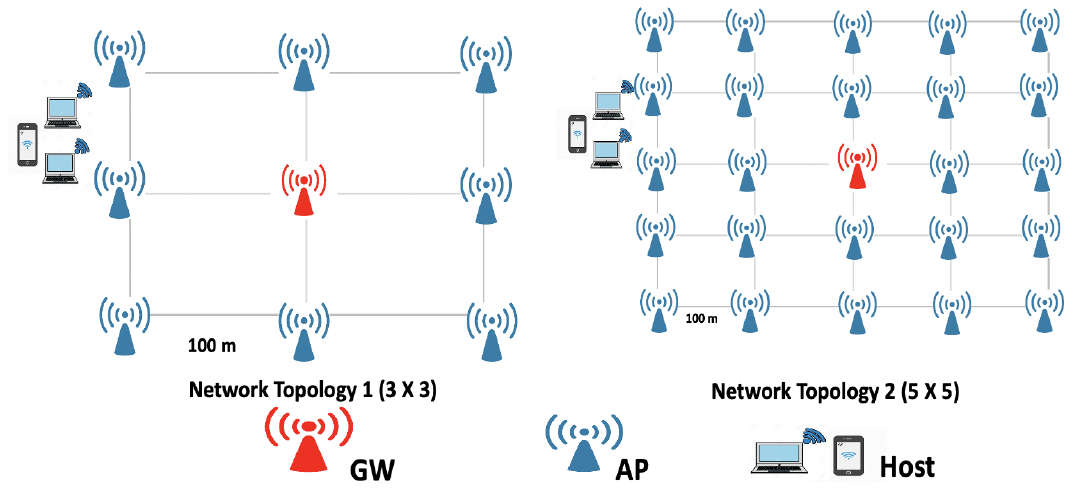
Figure 3. Simulation network topologies.